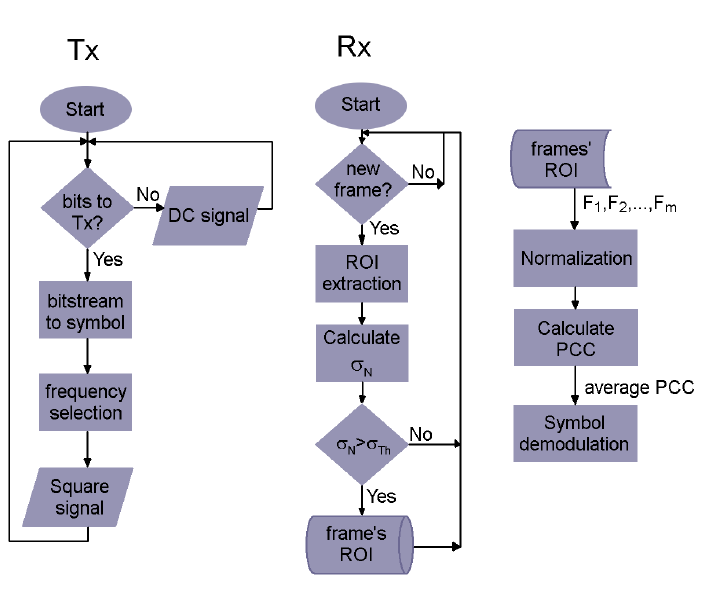
Figure 7. General flow chart of the proposed modulation